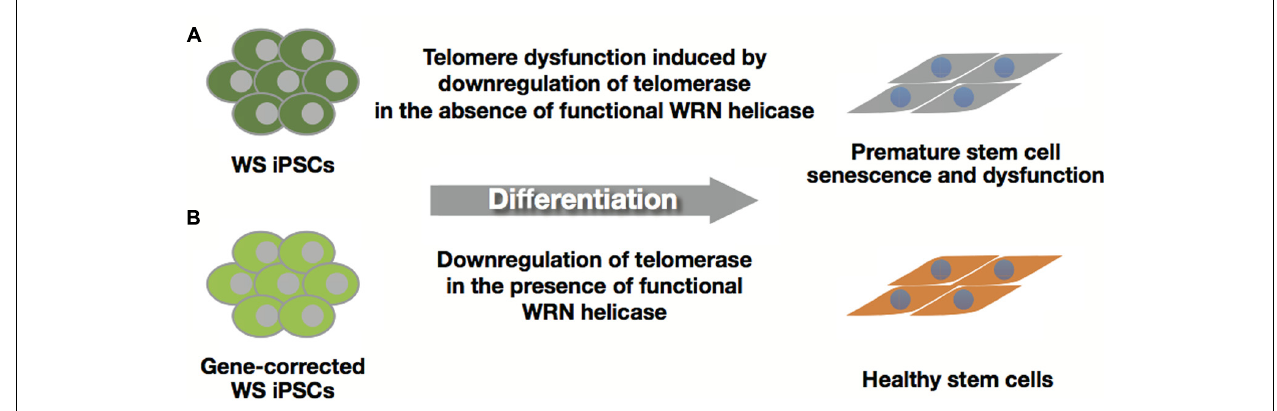
FIGURE 5 | Healthy stem cells from gene-correctedWS iPSCs. (A) WS iPSC-derived stem cells with insufficient levels of telomerase activity induce premature senescence and stem cell dysfunction. (B) Gene-correctedWS iPSCs can produce healthy stem cells by suppressing premature senescence due to functionalWRN